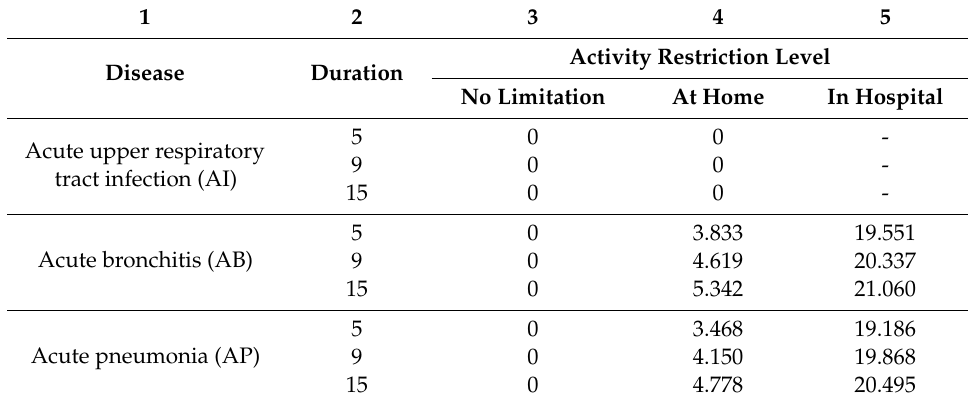
Table 6. Average WTP estimates by disease, activity restriction and duration (RMB per